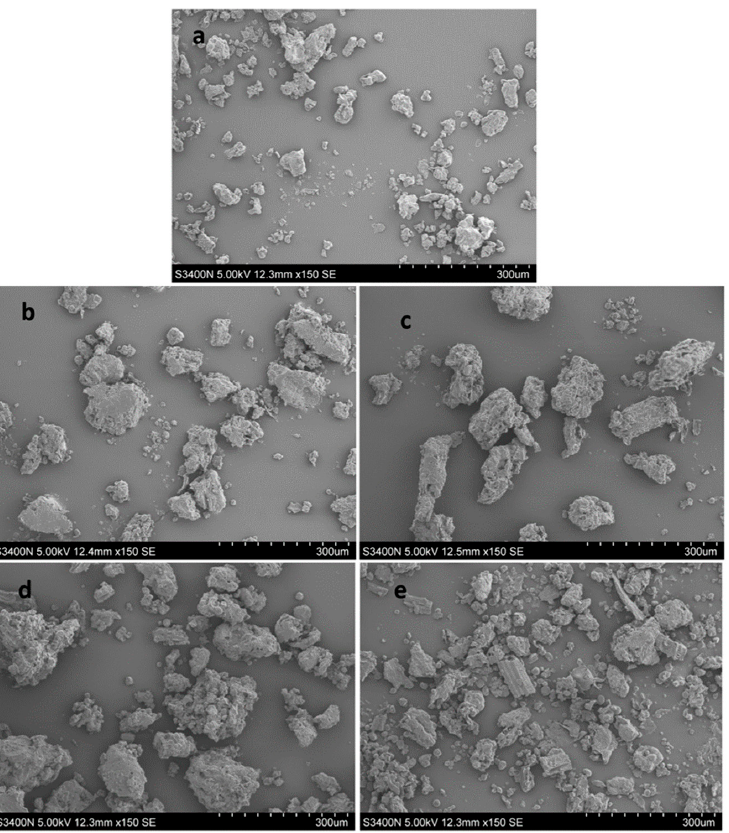
Figure 4 . The SEM photos of ( a ) the unextracted crude drug powder, ( b ) ultrasonic-assisted metha- nol extraction with enzyme pretreatment, ( c ) ultrasonic-assisted 70% ethanol extraction with en- zyme pretreatment, ( d ) ultrasonic-assisted DESs extraction and ( e ) ultrasonic-assisted DES extrac- tion with enzyme